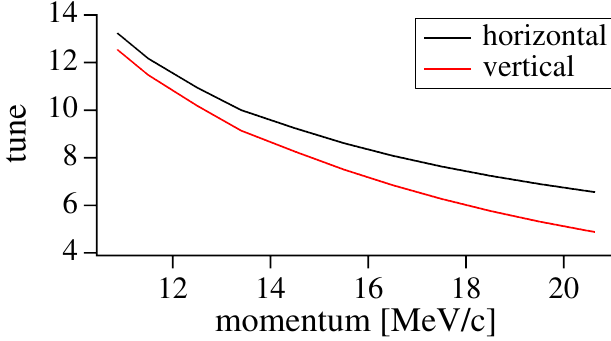
FIG. 1. (Color) Horizontal and vertical total tune as a function of